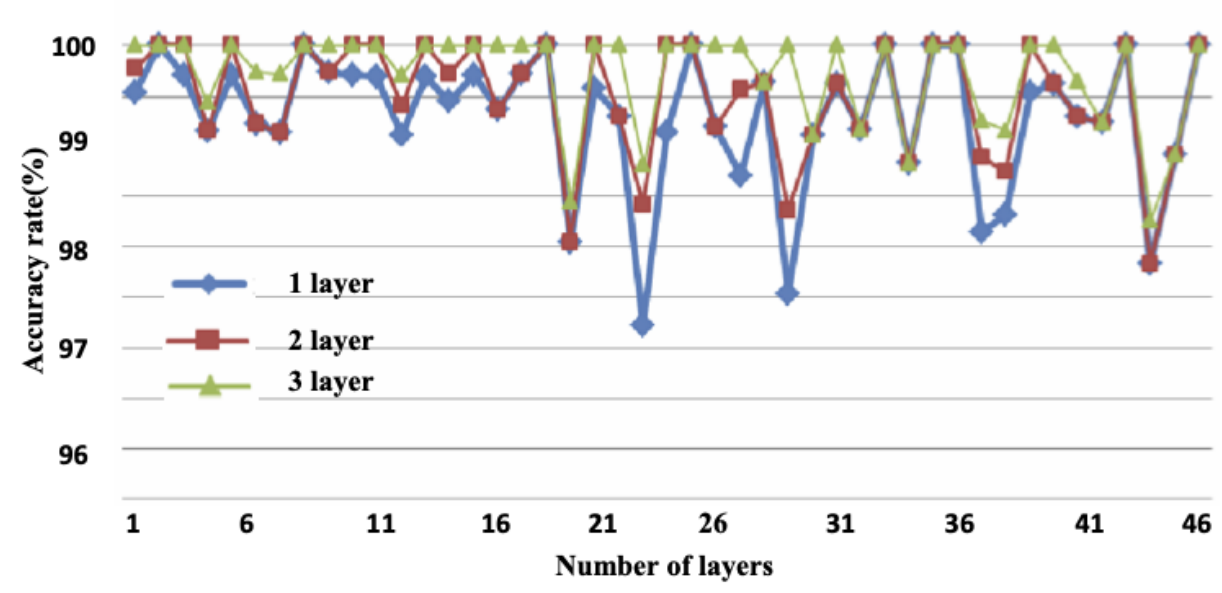
Figure 4. Classification accuracy of the USPS data set at different